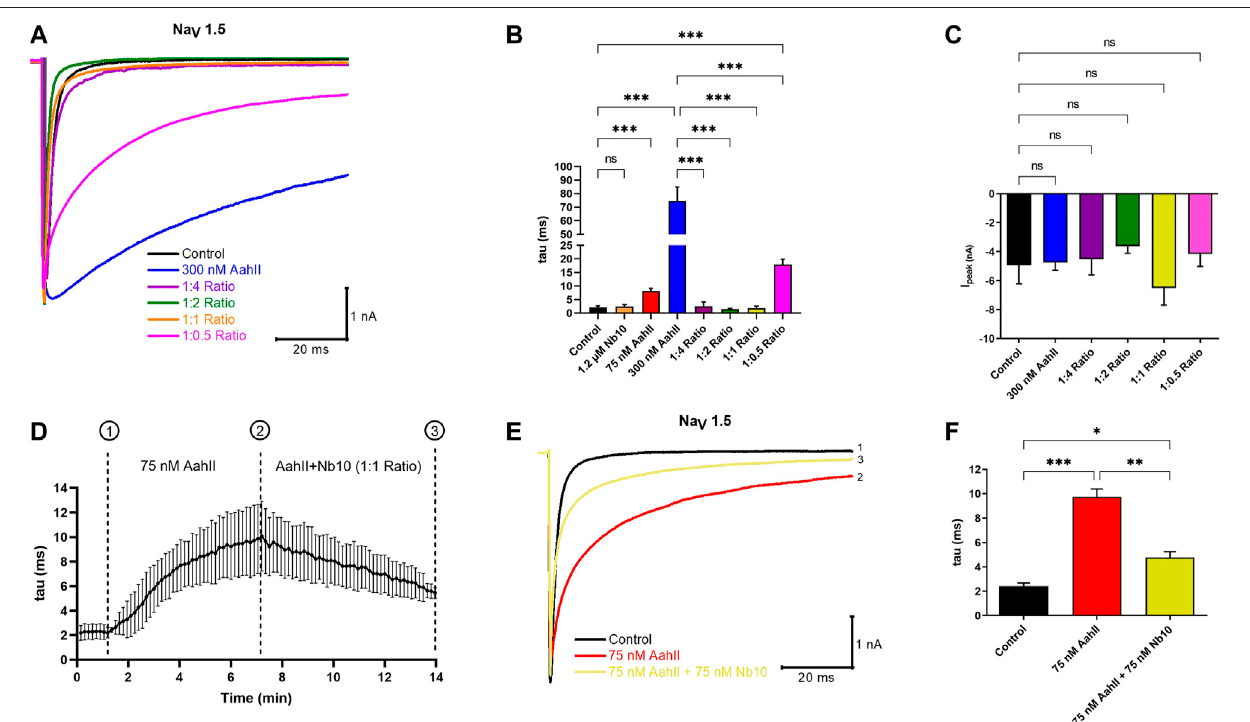
FIGURE 2 | Nb10 interacts with AahII on the Na V 1.5 channel. (A) Original whole-cell Na + current traces recorded at − 40 mV in control conditions (Control), in the presence of 300 nM AahII alone, 1.2 µM Nb10 alone, or at different ratios of [AahII]: [Nb10]. 1:4 ratio ([AahII] = 300 nM: [Nb10] = 1.2 µM); 1:2 ratio ([AahII] = 300 nM: [Nb10] = 600 nM), 1:1 ratio ([AahII] = 300 nM: [Nb10] = 300 nM), and 1:0.5 ratio ([AahII] = 300 nM: [Nb10] = 150 nM). (B) Mean of Na V 1.5 channel inactivation time constant (tau) in control conditions (control), AahII, and Nb10 alone and combined at different ratios. Values are representative of independent experiments, n = 5. All data are presented as mean ± SE (*** p < 0.001). (C) Mean of Na + current amplitude recorded at -40 mV in the same conditions as in panel (A) . Values are representativeofindependentexperiments, n =5.Alldataarepresented asmean±SE(*** p < 0.001). (D) MeanofkineticsoftheinactivationtimeconstantoftheNa V 1.5 channel (tau) following perfusion of AahII toxin at 75 nM from 1 to 7 min followed by the perfusion of a mixture of AahII and Nb10 at a 1:1 ratio up to 14 min. Traces are representative of independent experiments, n = 3. All data are presented as mean ± SE. (E) Representative of whole-cell Na + current traces recorded at -40 mV in the same conditions as in panel (D) , Na + current recorded in control conditions (Trace 1), after 7 min of AahII perfusion (Trace 2), and perfusion of AahII and Nb10 at a 1:1 ratio up to 14 min (Trace 3). Traces are representative of independent experiments, n = 3. (F) Mean of inactivation time constant of the Na V 1.5 channel (tau) following a similar protocol as in panel (D). Values are representative of independent experiments, n = 3. All data are presented as mean ± SE (*** p <